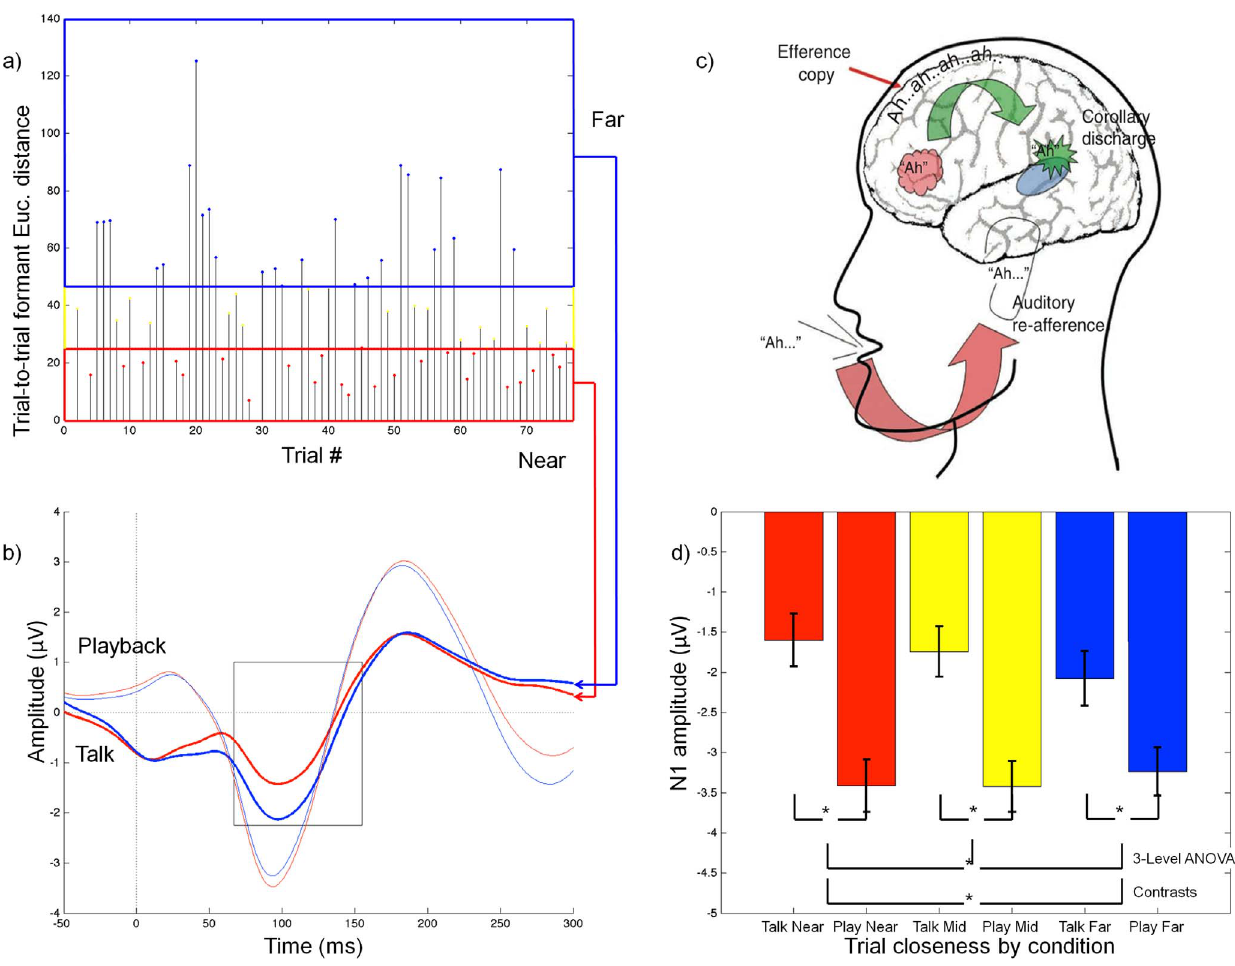
Figure 1. Relationship between trial-to-trial formant change and N1 suppression. Examples of trial sorting for one subject, a forward model, and the average event-related potentials (ERPs) of similar and dissimilar trials across all subjects. (a) We estimated each ‘‘ah’’ utterance’s first two formant frequencies to find the Euclidean distance between each ‘‘ah’’ and its preceding neighbor. We grouped these trials into thirds: Near, Mid, and Far (referring to their formant similarity to the preceding utterance) and trimmed-mean averaged each grouping together. (b) Grand average ERPs from 99 subjects, recorded from the midline frontal site (Fz), for Talk and Playback conditions for Near and Far trials. Data points with significant Talk Near versus Far differences boxed and include the N1 ERP component (paired t-test, two-tailed, p , 0.05). (c) Proposed framework for our findings. Premotor cortex sends an efference copy of a planned action to auditory cortex, where a corollary discharge is formed that represents the expected sensory consequences of the planned speech act. The actual percept is then compared to the predicted percept. Mismatch between predicted and actual percepts may be responsible for reduced suppression during Talk (from Mathalon et al. 2008)[35]. (d) Average N1 amplitude across all subjects and fifteen frontal-central electrodes with standard error bars. Talk versus Playback N1 effect at all trial groupings represents N1 suppression ( p =.001). We found an overall trial Consistency effect on N1 suppression ( p =.048) as well as a greater Near versus Far effect on SIS ( p =.014), showing decreased N1 suppression when an utterance varies highly from its previous